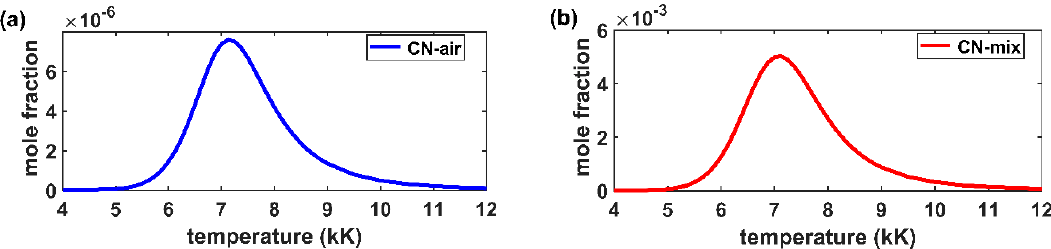
Figure 8. CN ( a ) air and ( b ) mixture mole fraction vs. temperature in chemical equilibrium, CN shows a maximum near 7 kK for the 1:1 mole ratio CO 2 :N 2 mixture at 1 atm. CN fractions in air are nearly three orders of magnitude lower than that for the mixture.